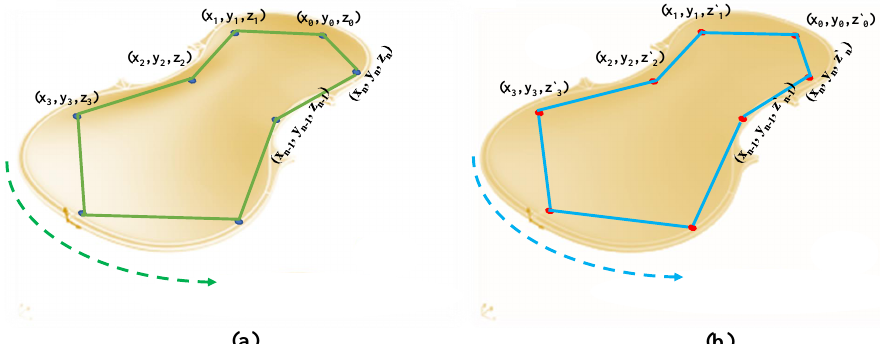
Figure 5. Material removal depth on violin surface ( a ) z-position before polishing ( b ) z-position after